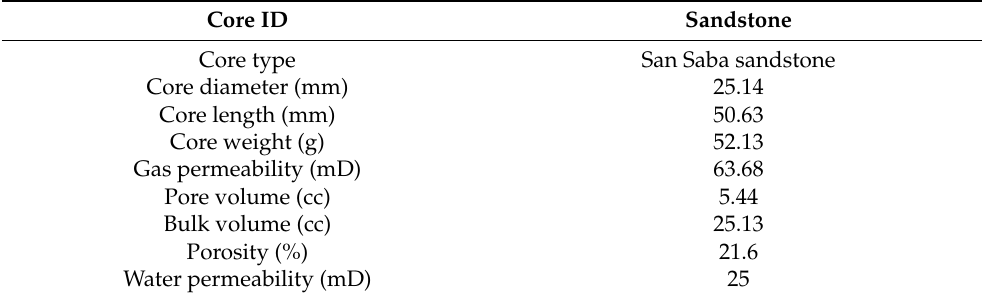
Table 3. Core sample physical